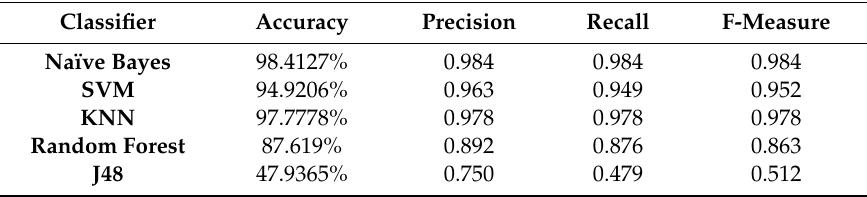
Table 6. Performance metrics for the power bin approach (0.5 MHz bin